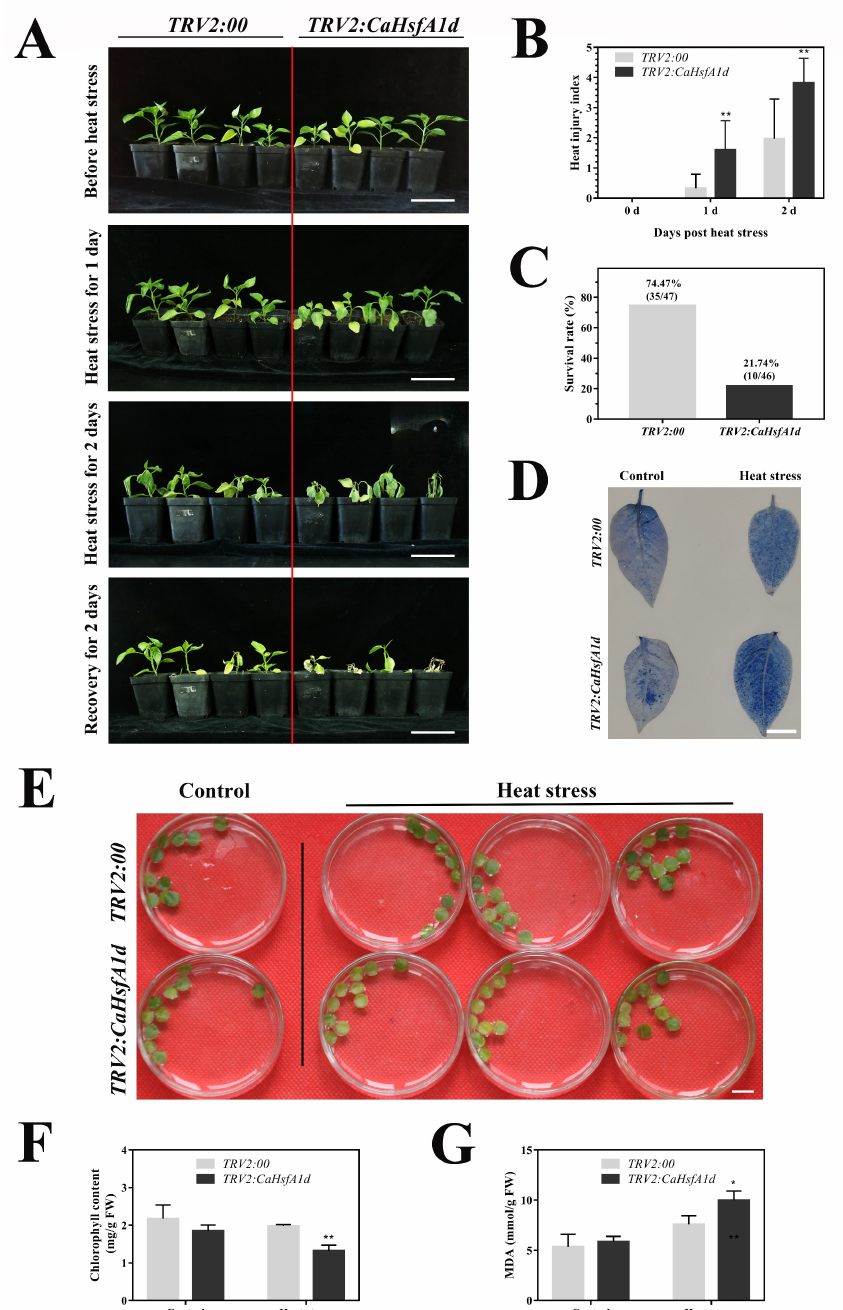
Figure 5. Thermotolerance analyses of CaHsfA1d -silenced pepper seedlings. ( A ) Appearance of TRV2:00 and TRV2:CaHsfA1d pepper plants before heat treatment, after heat treatment, and after recovery. Scale bar = 10 cm. ( B ) Heat injury index scored daily for TRV2:00 and TRV2:CaHsfA1d pepper plants after heat treatment in Figure 5A. ( C ) Survival rate of TRV2:00 and TRV2:CaHsfA1d seedlings after recovery in Figure 5A. ( D ) Trypan blue coloration in the leaves of TRV2:CaHsfA1d pepper plants compared with TRV2:00 after 45 ◦ C treatment for 2 h. Scale bar = 1 cm. ( E ) The phenotype of leaf discs isolated from TRV2:00 or TRV2:CaHsfA1d plants at 12 h post 37 ◦ C heat stress. Scale bar = 1 cm. ( F ) Chlorophyll and ( G ) MDA content of the leaf discs (Figure 5E) exposed to heat stress. Data are means ± SD of three biological replicates. The asterisks on the top of bars indicate significant di ff erences between the TRV2:00 and TRV2:CaHsfA1d plants. * p < 0.05, ** p < 0.01 by t